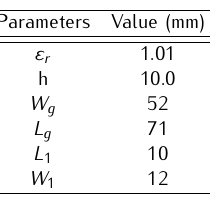
Table 1. Antenna design parameters.